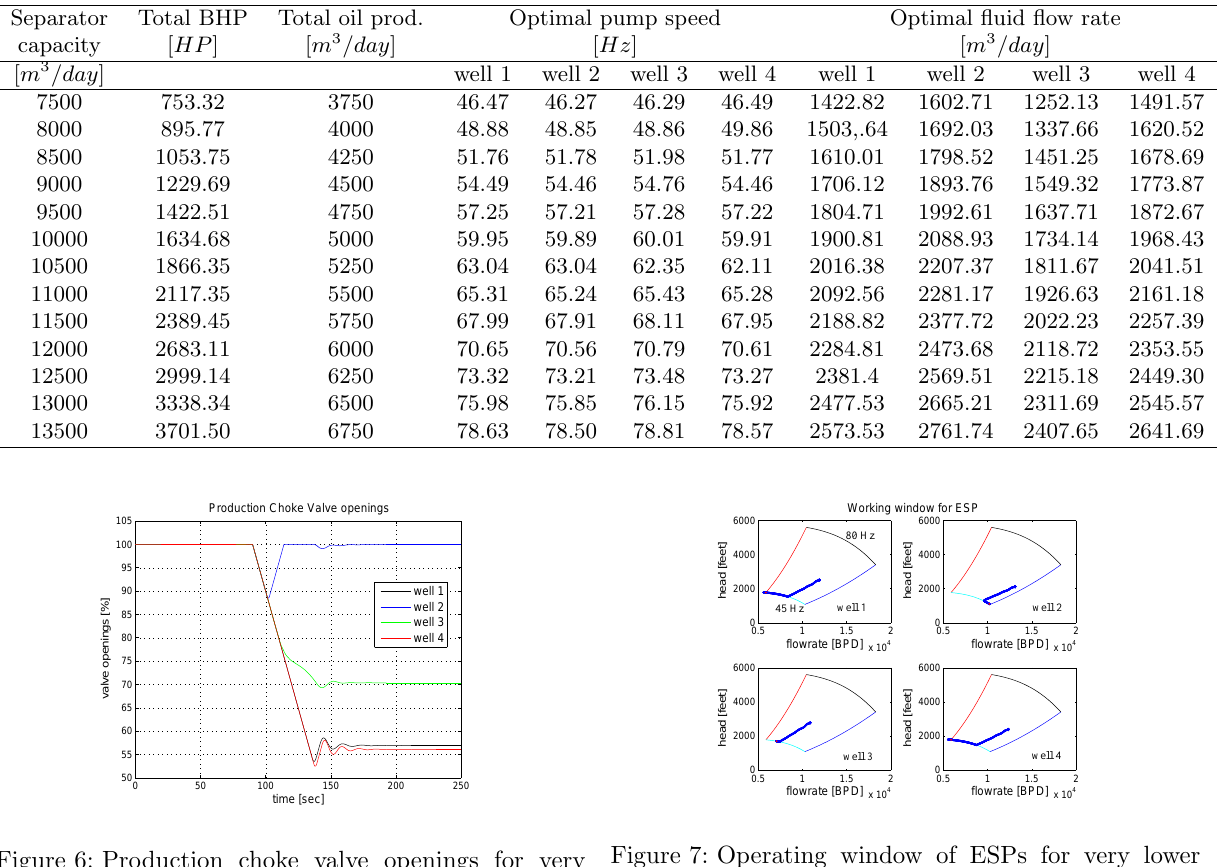
Table 1: Optimal operation of ESP oil field for different separator capacities for case I